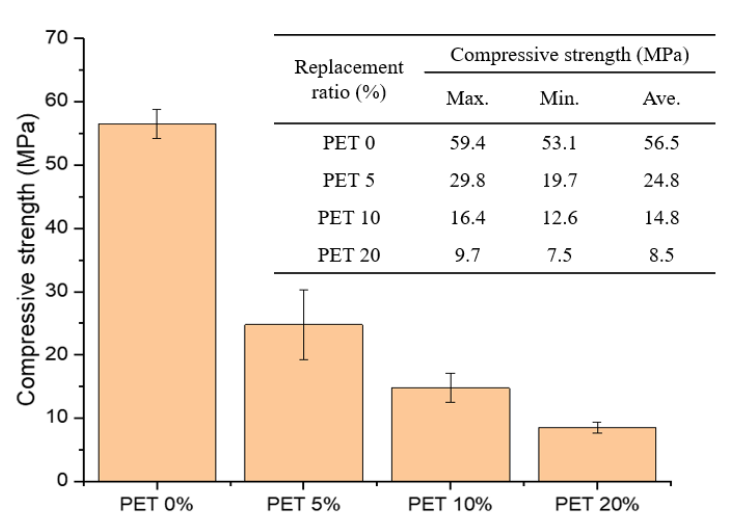
Figure 4. Average compressive strengths of cement paste samples with PET powder at different replacement ratios between 0 and 20%.